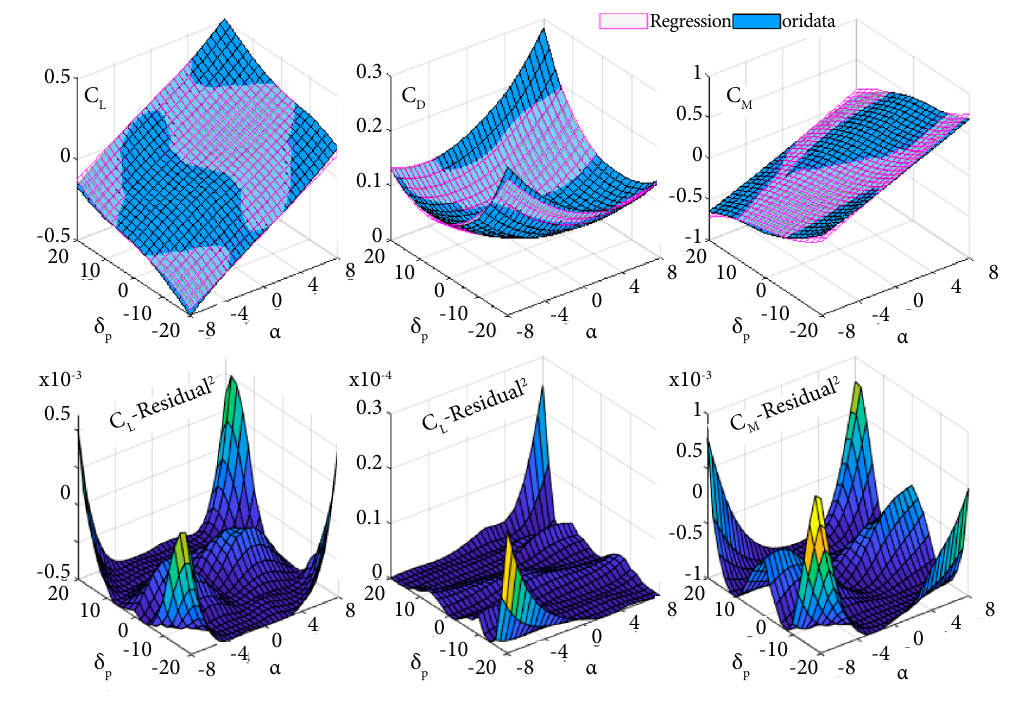
Figure 7. Direct qualitative error analysis of fitting model on M